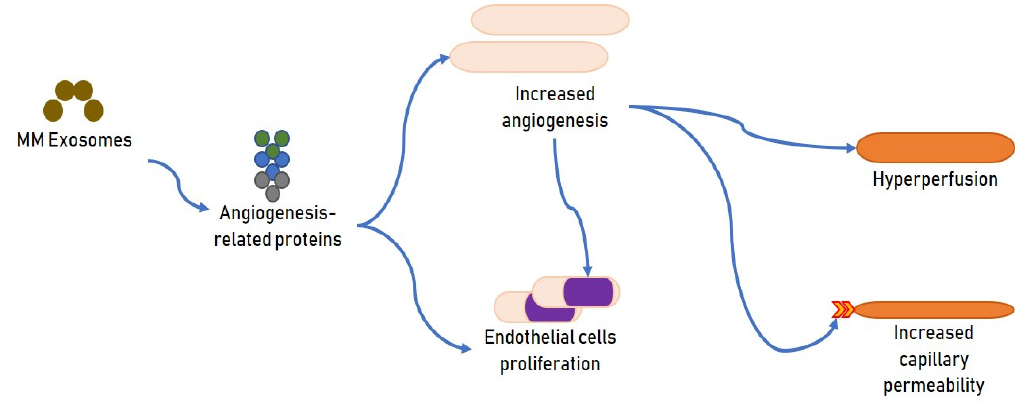
Figure 2. Effects of exosomes on angiogenesis.